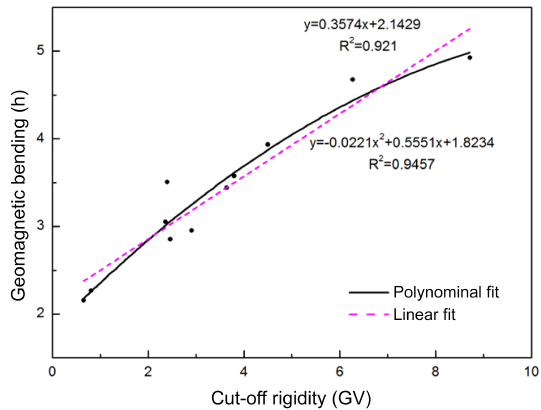
Figure 4. Diagram of the geomagnetic bending of all the stations with respect to their geomagnetic threshold